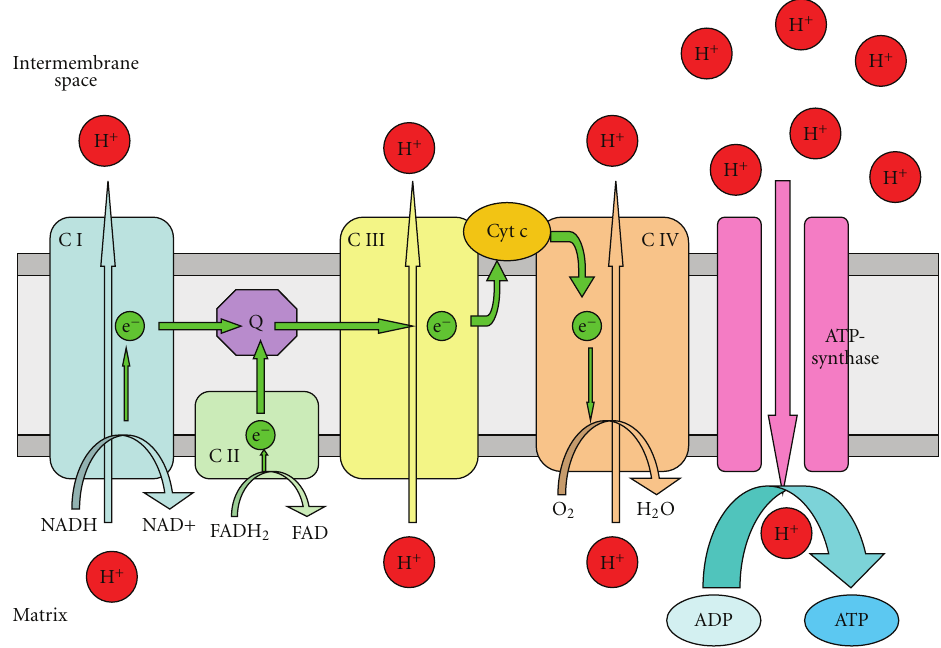
Figure 2: Mitochondrial electron transport chain: schematic representation of the mitochondrial electron transport chain involved in oxidative phosphorylation. CI and II (Complexes I and II) transport electrons (e − s) generated by the conversion of NADH to NAD+ (CI) or FADH 2 to FAD (CII) through Q (ubiquinone), CIII, Cyt c (cytochrome c) and finally CIV, which uses an e − to convert O 2 to H 2 O. During electron transfer, CI, II, and IV pump protons (H + s) from the mitochondrial matrix into the intermembrane space generating a H + concentration gradient that drives the formation of ATP from ADP by ATP-synthase (Complex